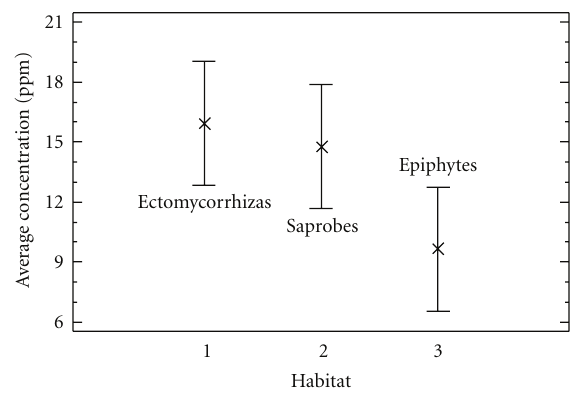
Figure 2: Mean value of trace element concentrations (averaged over the 18 elements measured and the seven species in each lifestyle) for each of the three lifestyles studied. The results of an ANOVA test are also shown.